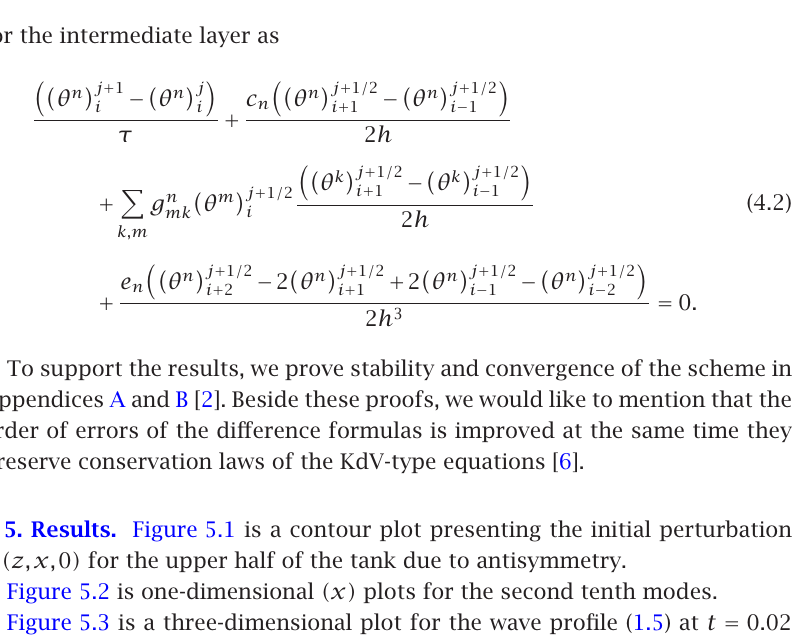
Figure 5.3 is a three-dimensional plot for the wave profile (1.5) at t = 0 . 02 second for the same half of the tank.